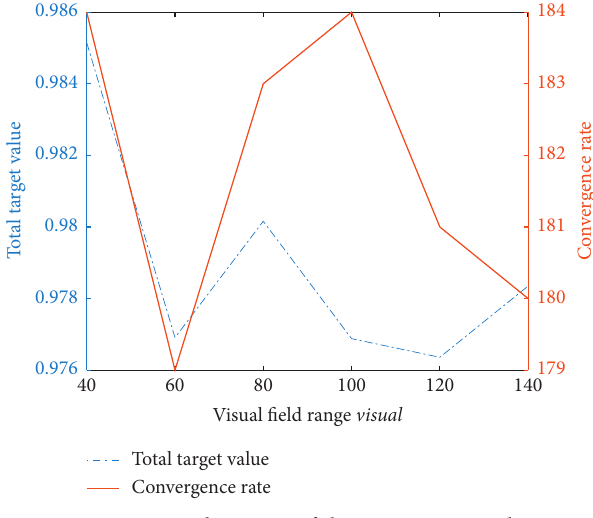
Figure 4: Adjustment of the parameter visual